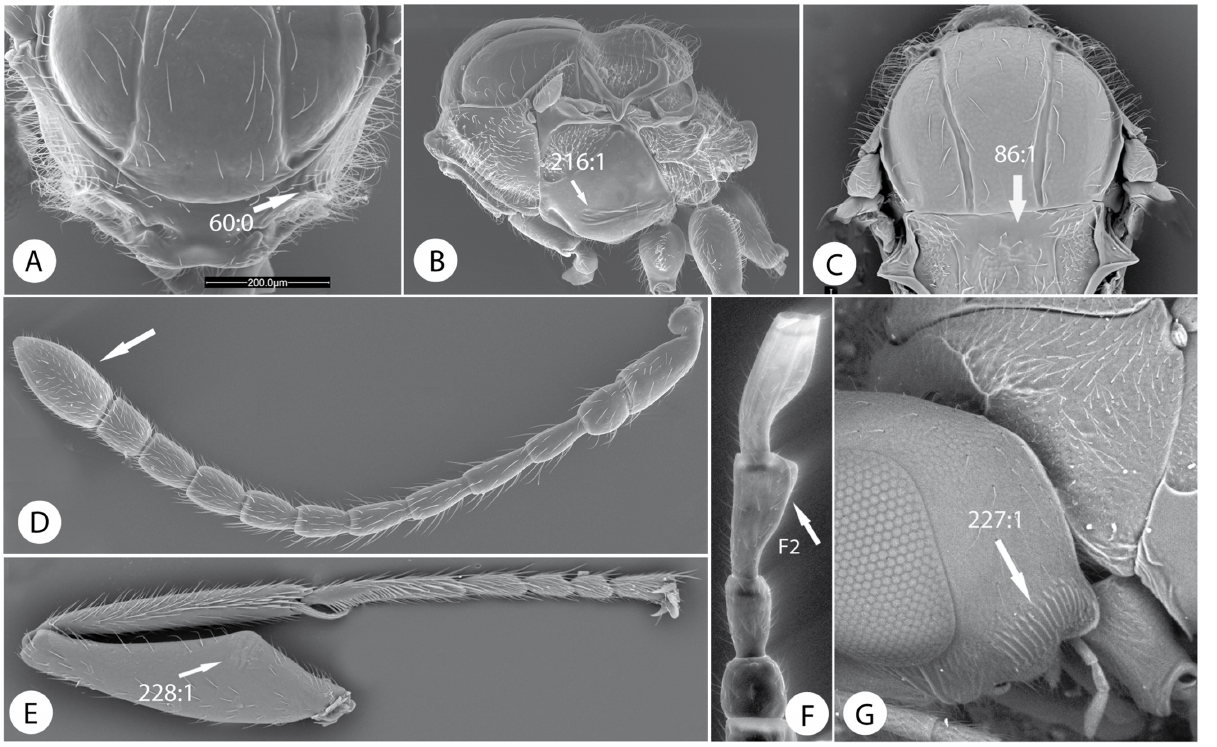
Fig 9. Morphological characters of Paraulacini. Cecinothofagus gallaelenga Nieves-Aldrey & Liljeblad: A) pronotum, anterior view. B) mesosoma lateral view. C) mesosoma dorsal view. D) antenna of female. E) profemur. F) first flagellomeres of male antenna. G) head lateral view, showing vertical carinae on